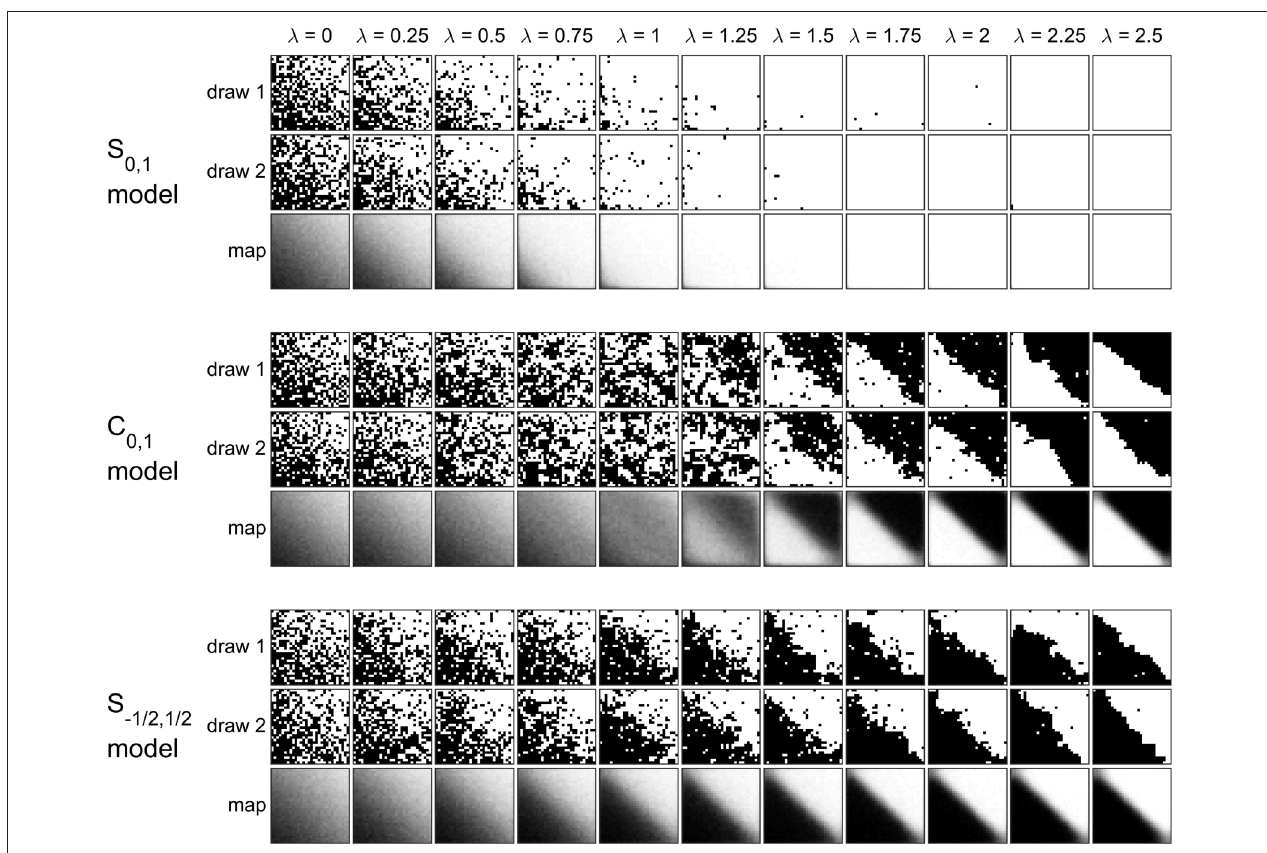
FIGURE 7 | Effect of λ on three model variants when β estimated marginal probability map. The realizations are displayed as images with black and white pixels representing the low and high states,